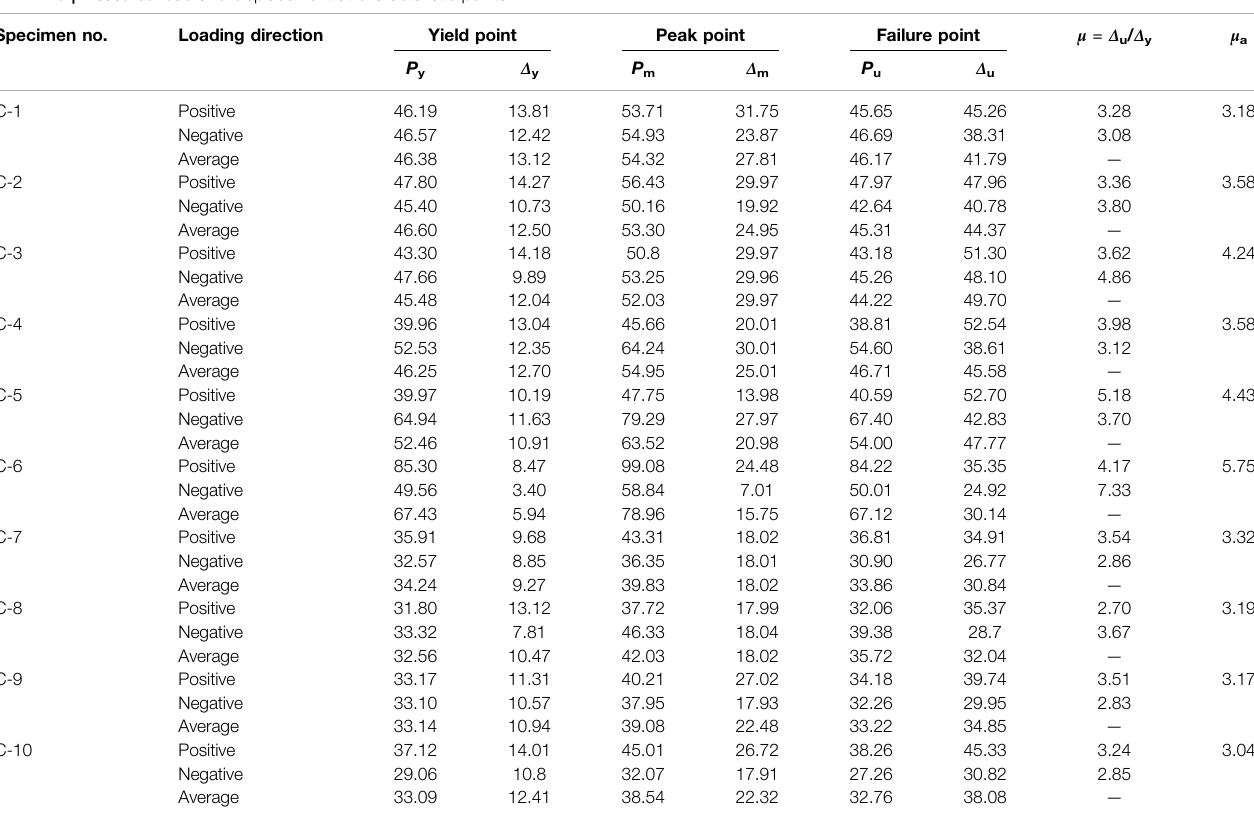
TABLE 6 | Measured load and displacement at characteristic points. Specimen